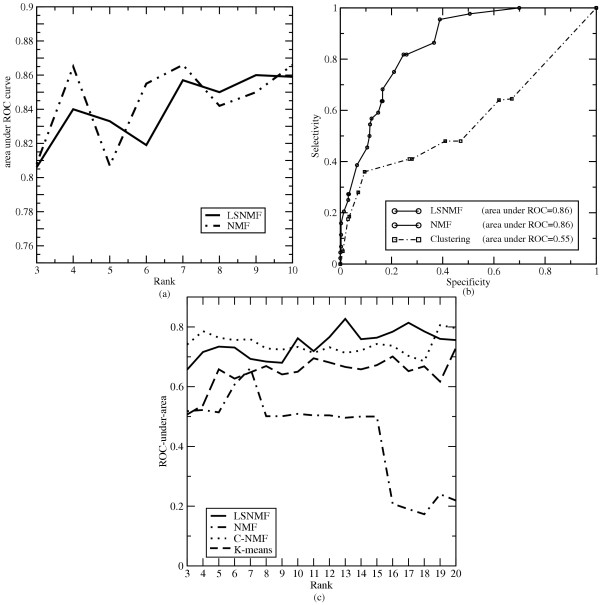
ROC Analysis of Yeast Cell Cycle and Rosetta Data Sets. ROC analysis for NMF and LS-NMF for the yeast cell cycle data is summarized in sections a and b, while section c shows the results for the Rosetta Compendium analysis, where variance estimates are available. In a, the total area under the ROC curves is shown for LS-NMF (solid line) and NMF (dashed line). In b, LS-NMF and NMF are compared to hierarchical clustering at a single dimensionality (the LS-NMF and NMF curves are superimposed as there is no difference). In c, the areas under the ROC curve for analysis of the Rosetta data are shown for LS-NMF (solid line), NMF (dash-dot line), K-means clustering (dashed line), and NMF on scaled data (C-NMF, dotted line). Here the variance information allows far better results to be obtained, either by scaling or by use of LS-NMF. The advantages of the approach used in LS-NMF are discussed in the text.